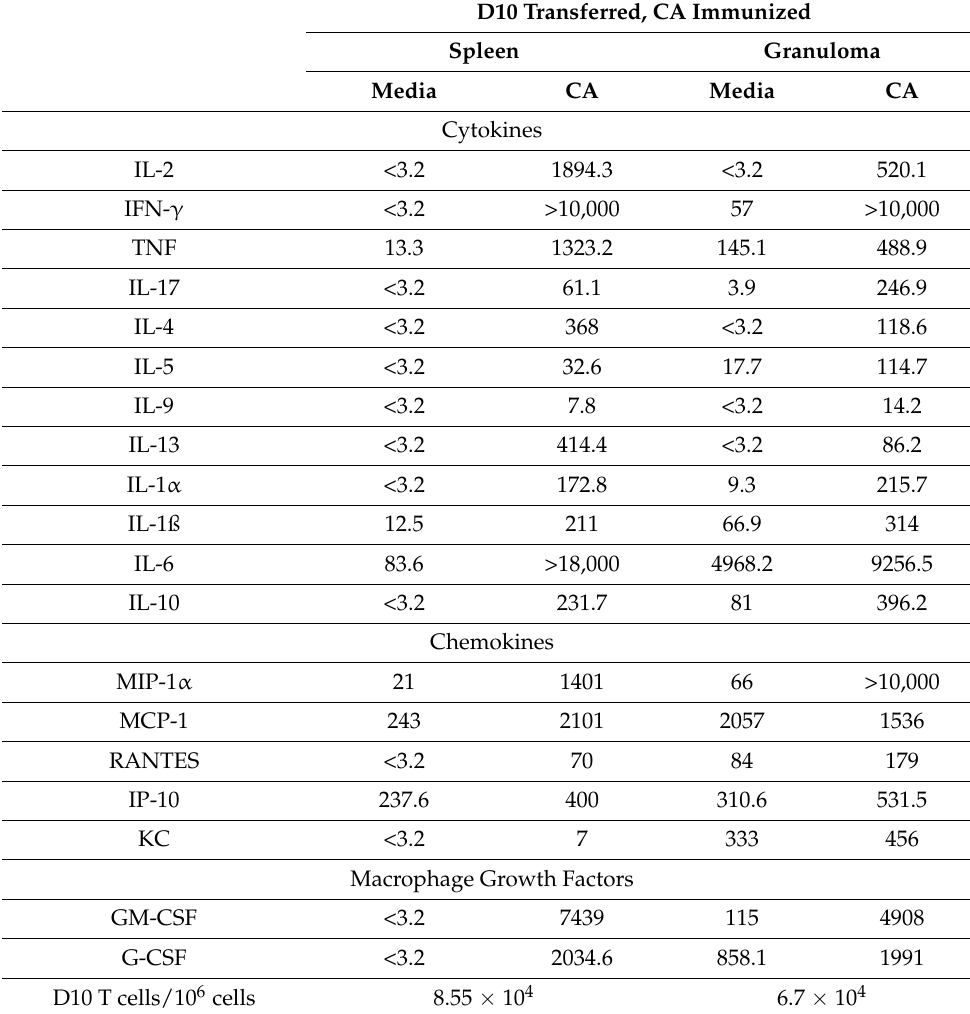
Table 1. Activated non-Specific T cells have the Potential to Produce a Diverse Set of Cytokines and Chemokines 1 .